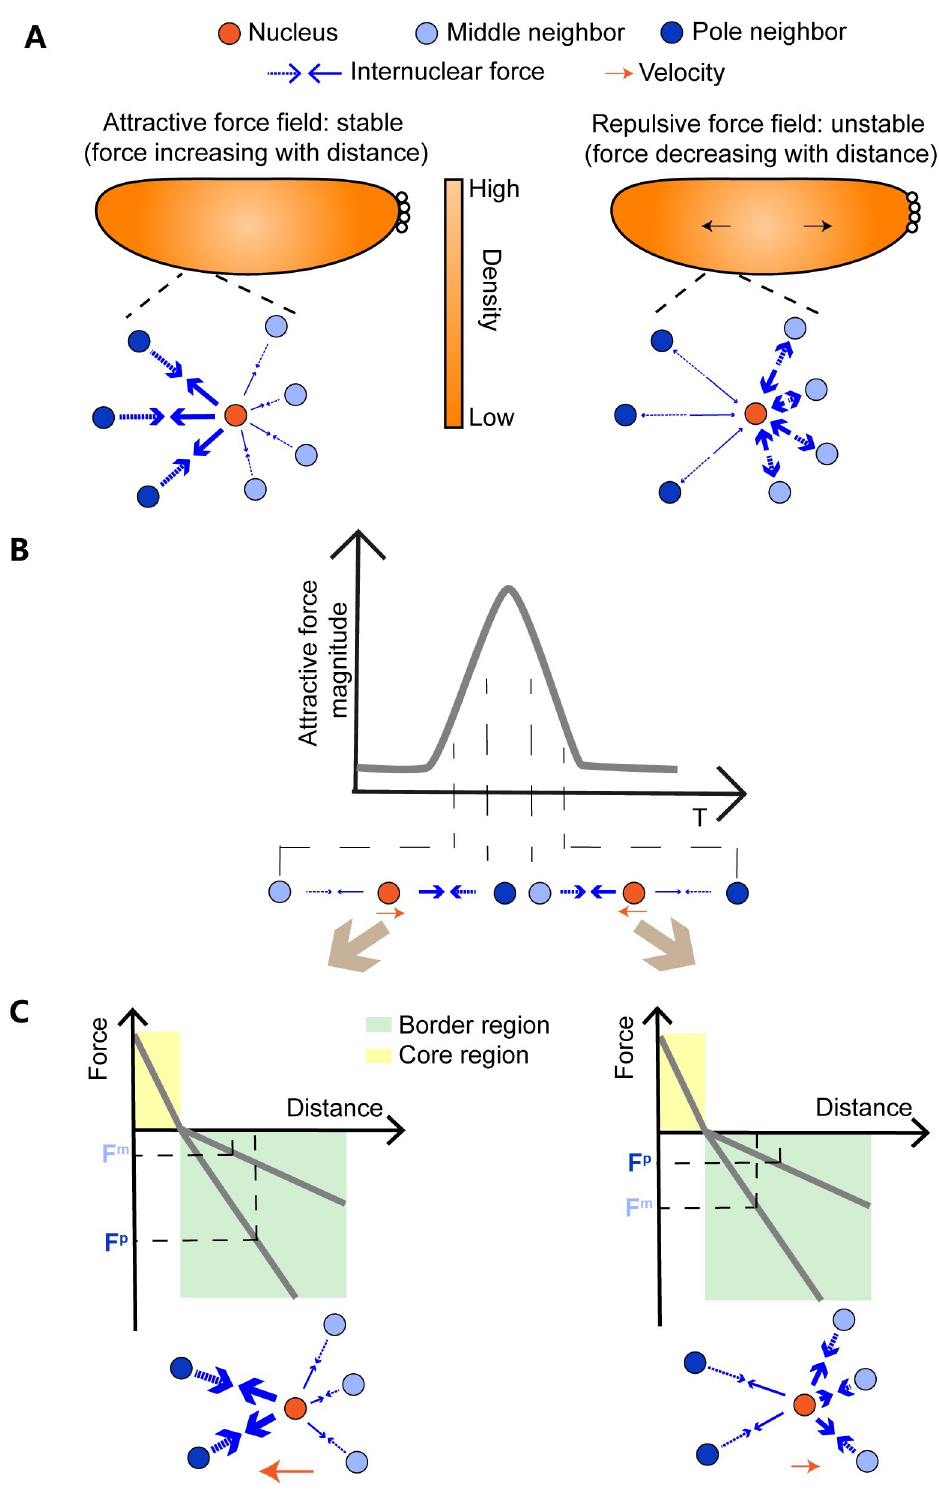
Fig 6. The intrinsic properties of the force fields generate the characteristic features of the collective behaviors of the nuclear array. (A) Asymmetric distribution of the nuclear density is stabilized by the attractive but not repulsive force field. As the nuclear density is high in the middle of the embryo, for a nucleus (orange circle), its nearest neighboring nuclei on the pole side (dark blue circles) are fewer in number but larger in the internuclear distance